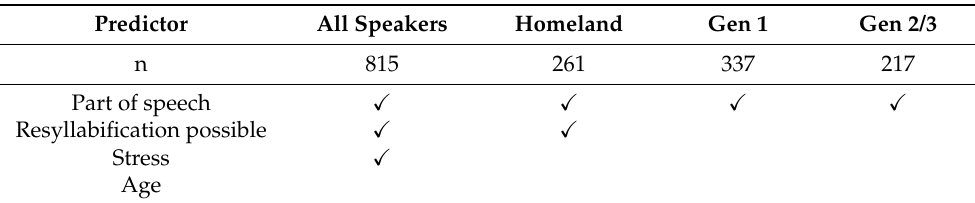
Table 7. Significant predictors (indicated with “ (cid:88) ”) in MEMs comparing Reduced vs. Deleted vowels, for each speaker